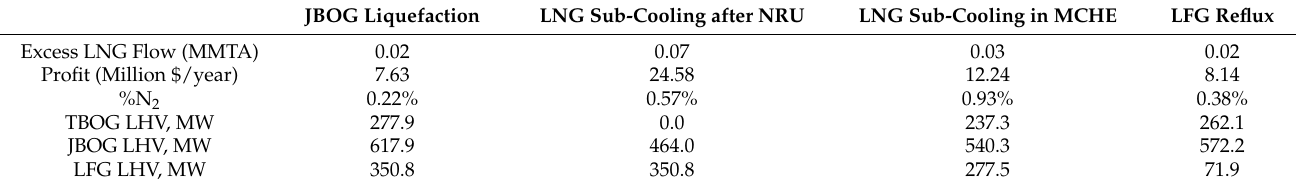
Table 2. BOG minimization/recovery strategies